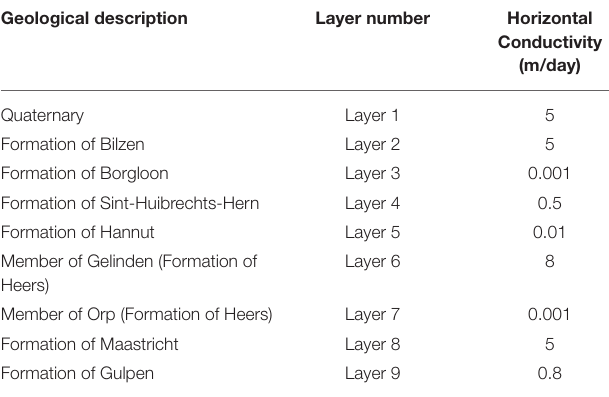
FIGURE 7 | (A–G) Scenarios for the implementation of fractured zones in the model. See the text for the description of the specific scenarios. TABLE 2 | Calibrated hydraulic conductivity for the homogeneous